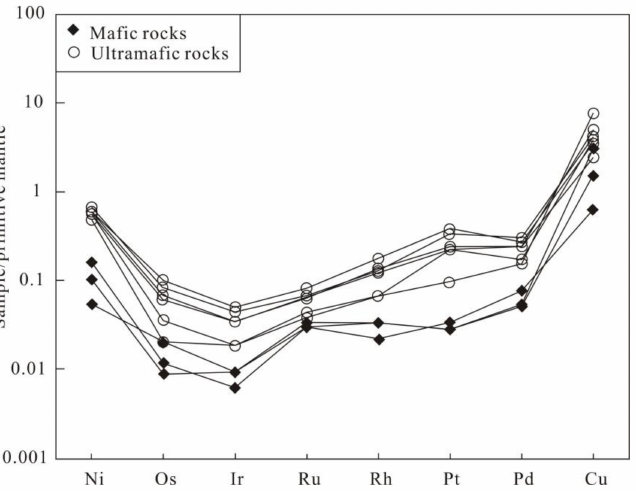
Figure 7. Primitive mantle-normalized platinum-group elements (PGE) patterns for the rocks from the Baixintan intrusion. The primitive mantle values are from